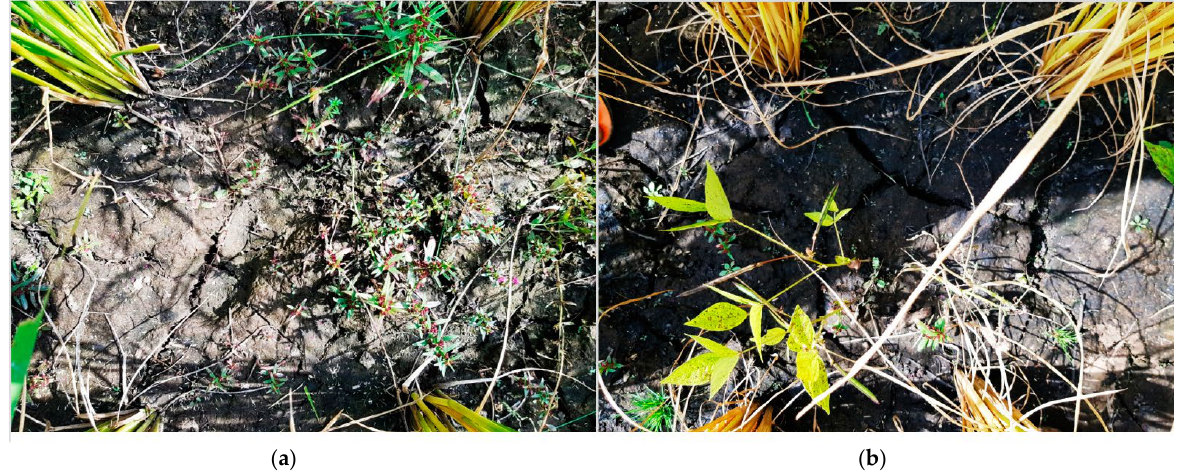
Figure 2. A comparison of weed infestation: ( a ) SRI weedy control, SRI-w; ( b ) SRI with intercropping, SRIBI (2019).